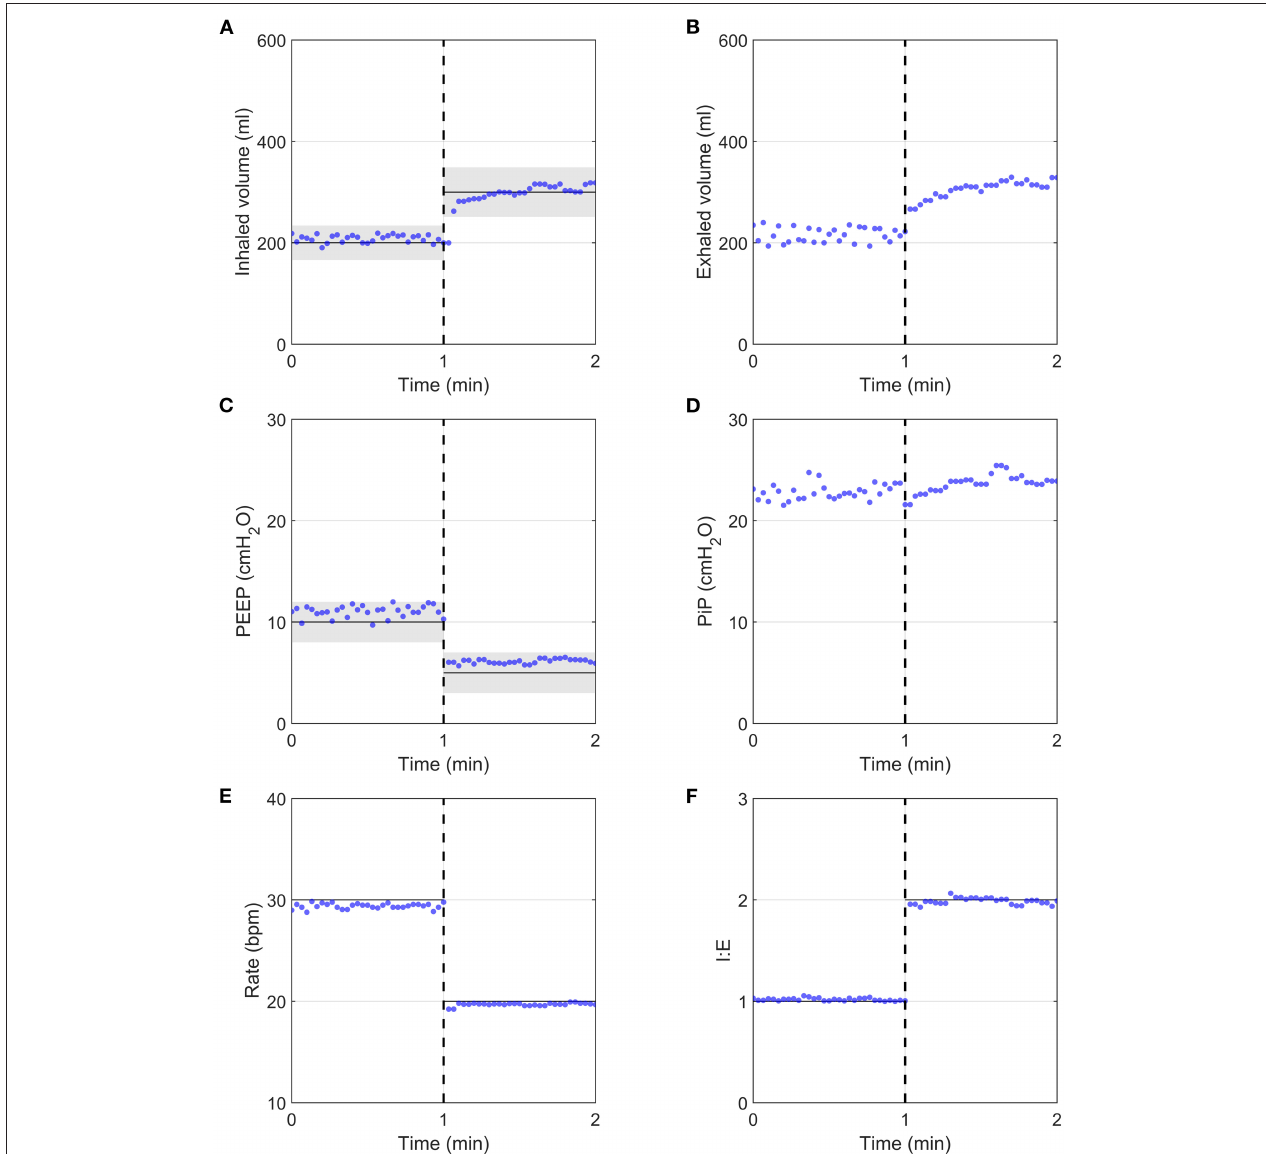
FIGURE 4 | System response after the programmatic changing of all clinical parameters simultaneously (dashed vertical lines), measured using the flow analyser. Input parameters are indicated by continuous black horizontal lines, with ISO 80601-2-12:2020 measurement uncertainties indicated by grey shaded regions, with ± (4ml + 15% of target value) for volume and ± 2 cmH 2 O for PEEP. (A) Inhaled volume, (B) Exhaled volume, (C) PEEP, (D) PiP, (E) Respiratory Rate, (F) I:E ratio.